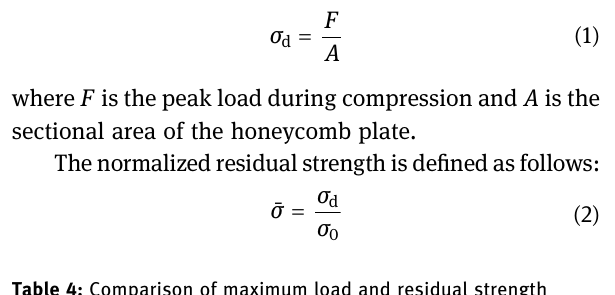
Table 4: Comparison of maximum load and residual strength Depth ( mm